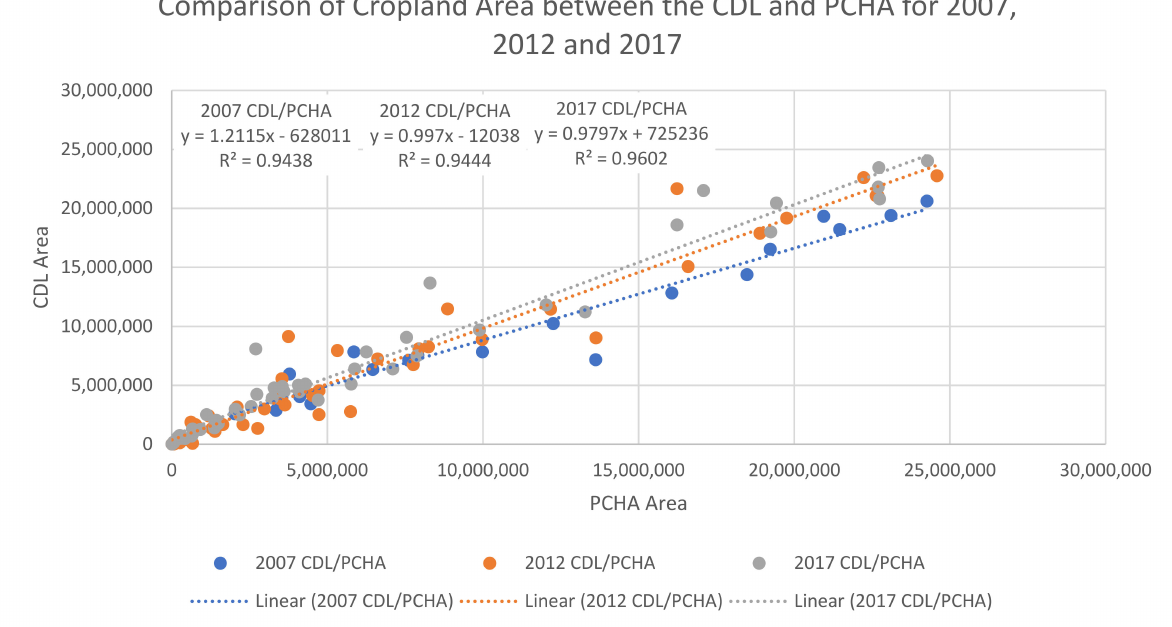
Figure 5. Relationships in total cropland area estimated using the CDL and PCH for 2007, 2012, and 2017.